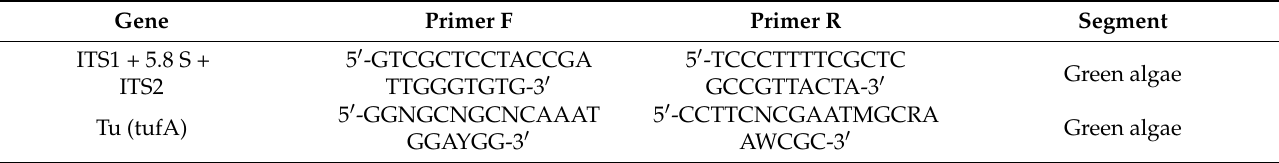
Table 1. Sequences of primers for the identification of microalgae.